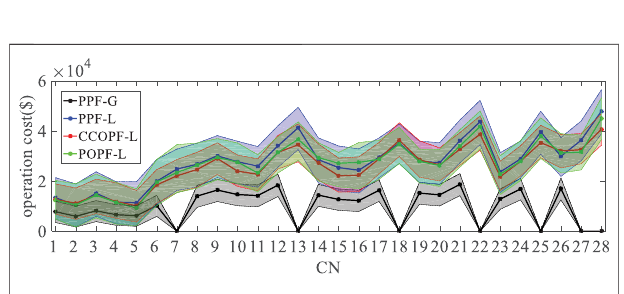
FIGURE 10 | Cost range of balancing power